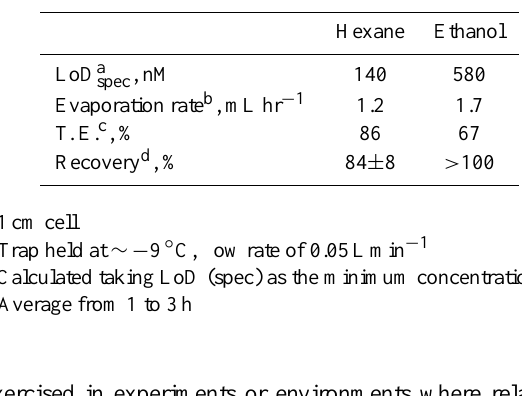
Table 2. Comparison of prototype solvent trap properties.